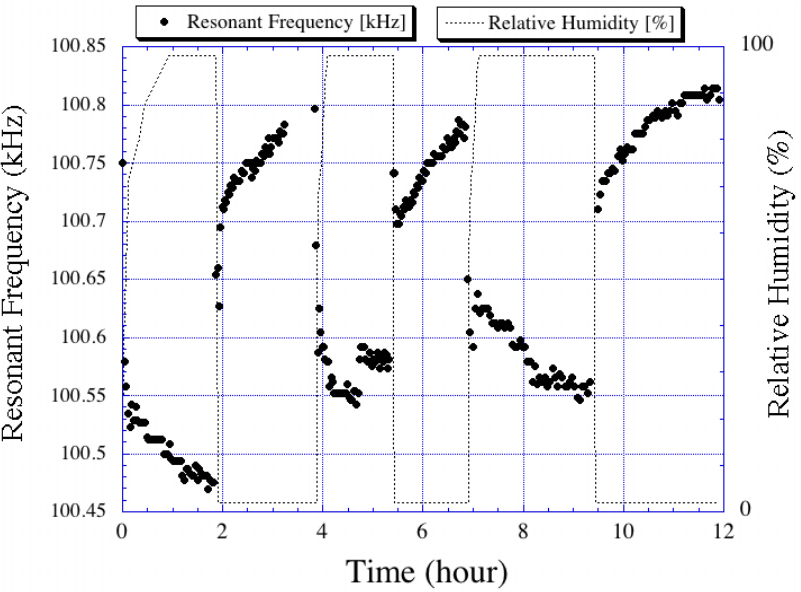
Figure 22. Resonance frequency of magnetoacoustic humidity sensor as a function of time as the sensor is cycled between 100% and 0% humidity ambients. Reprinted with permission from